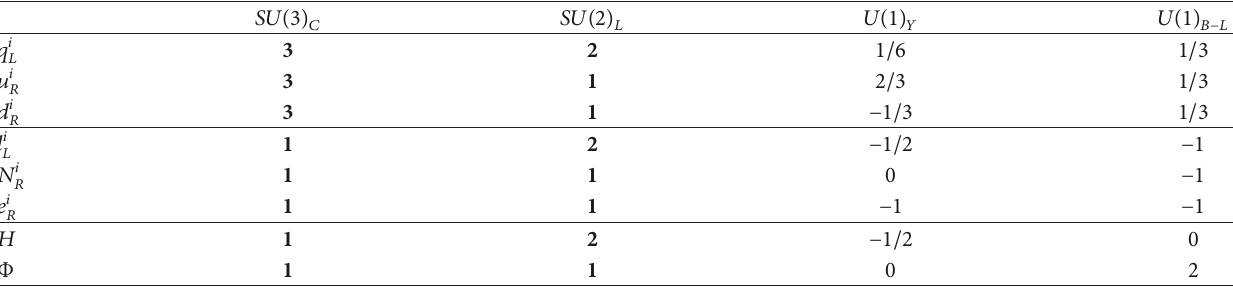
Table 1: Particle content of the minimal 𝐵 − 𝐿